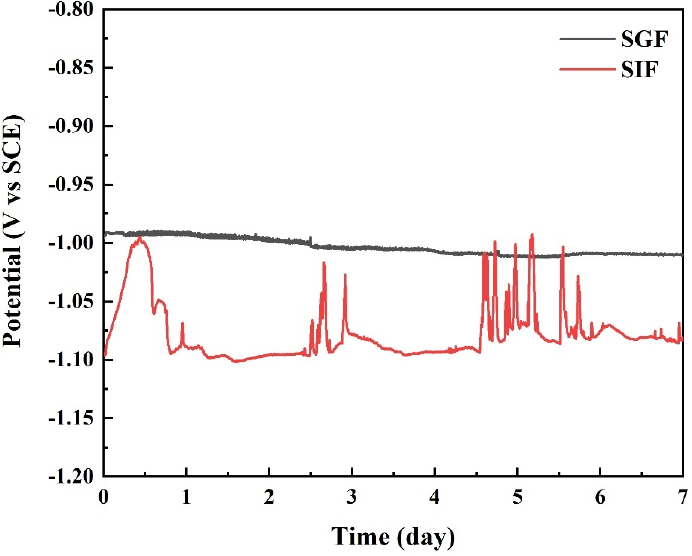
Figure 9. OCP evolution with time in the electrolytes of Zn–0.4Li immersed in SGF and SIF.